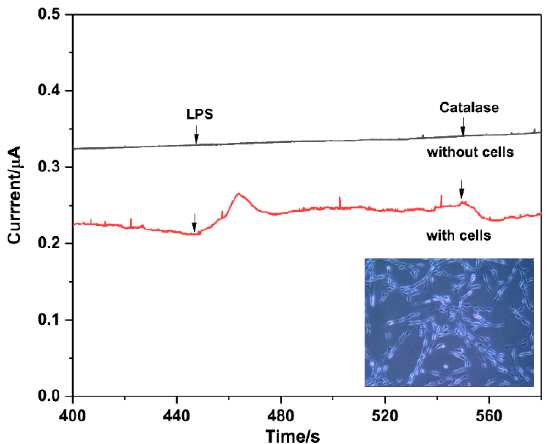
Figure 6. Amperometric responses of the Ag-mSiO 2 / GCE in 0.2 M PBS (pH 6.8) with the addition of LPS and catalase in the absence (upper curve) and presence (lower curve) of PC 12 cells .